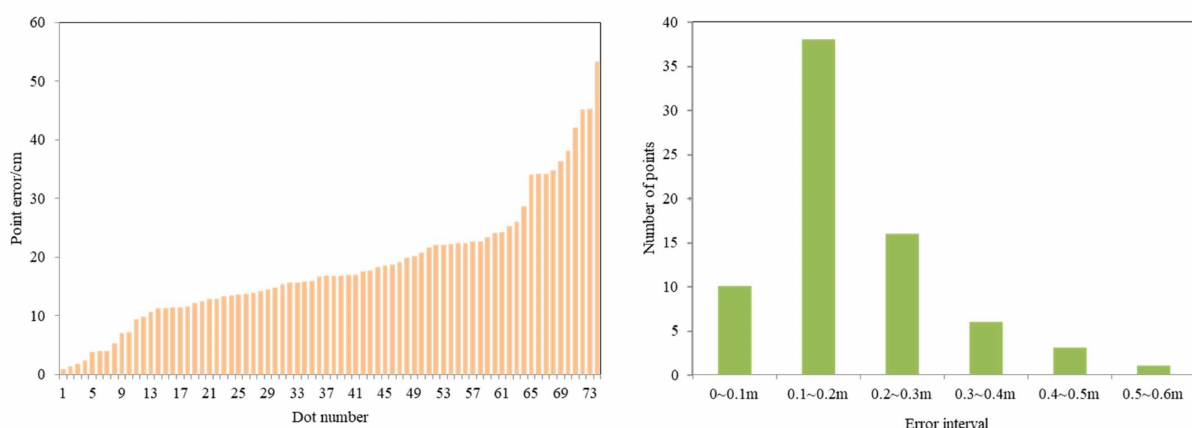
Figure 15. Detection of incorrect images.